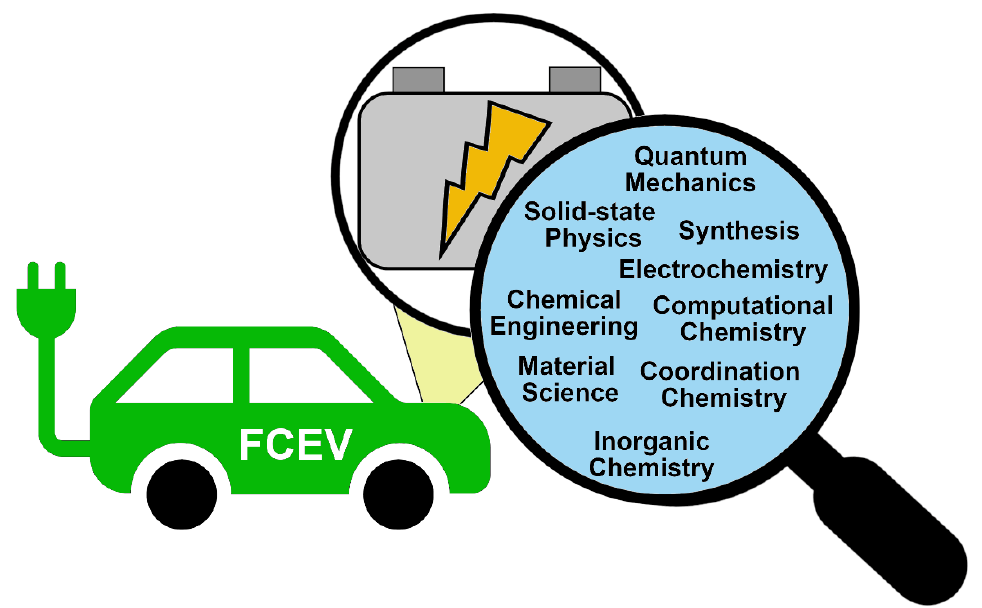
Figure 14. Disciplines involved in the development of PEMFC in fuel cell electric vehicles (FCEVs).